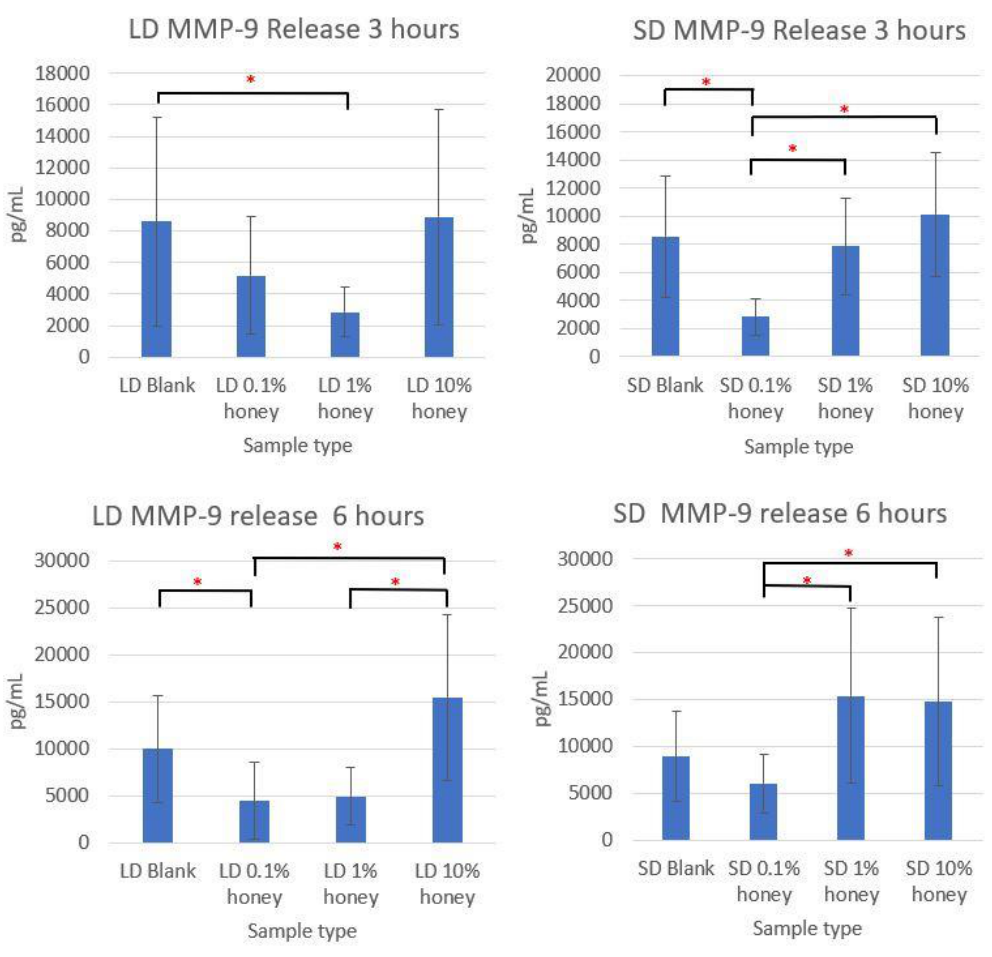
Figure 9. The 0.1% honey and 1% honey samples had the lowest MMP-9 release. The release of MMP-9 is shown on LD and SD templates at 3 and 6 h. * indicates a significant difference between the indicated samples within that template type and timepoint. Sample size of 4 replicates per timepoint per experiment, with 3 unique donor experiments. Raw data is available in Supplementary Spreadsheet 5.